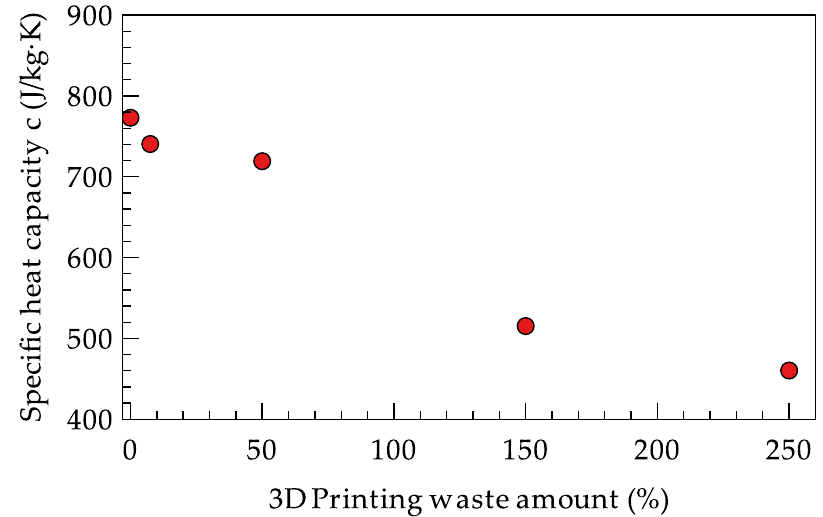
Figure 12. Specific heat capacity.